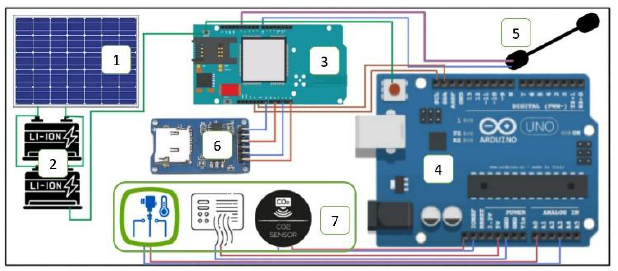
Figure 2. Schematic representation of the monitoring device and its components